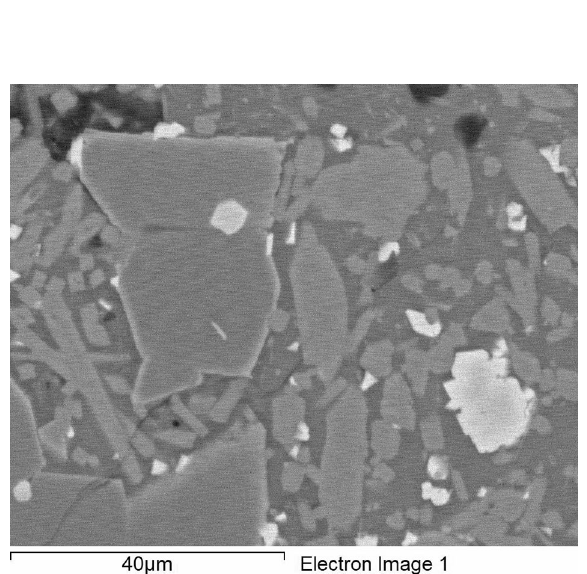
Figure 5. Scanning electron microscope image showing the size and shape of the LZS-1